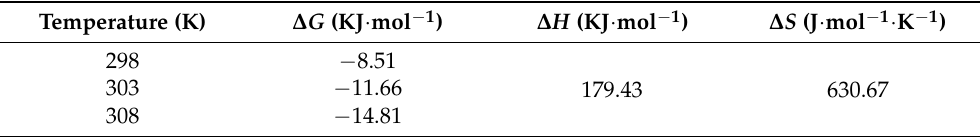
Table 5. Thermodynamic parameters for the adsorption of sulfonated lignite onto filter paper- templated Mg-Al metal